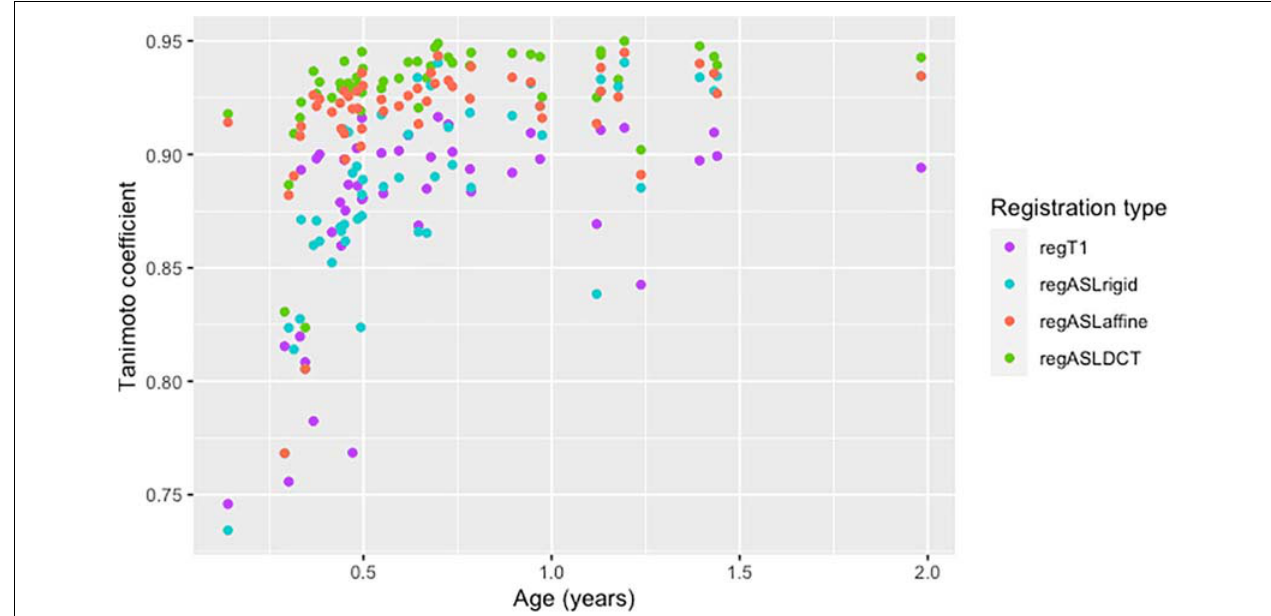
FIGURE 1 | A scatterplot of the Tanimoto coefficient of four registration types of the total cohort in time (age in years).